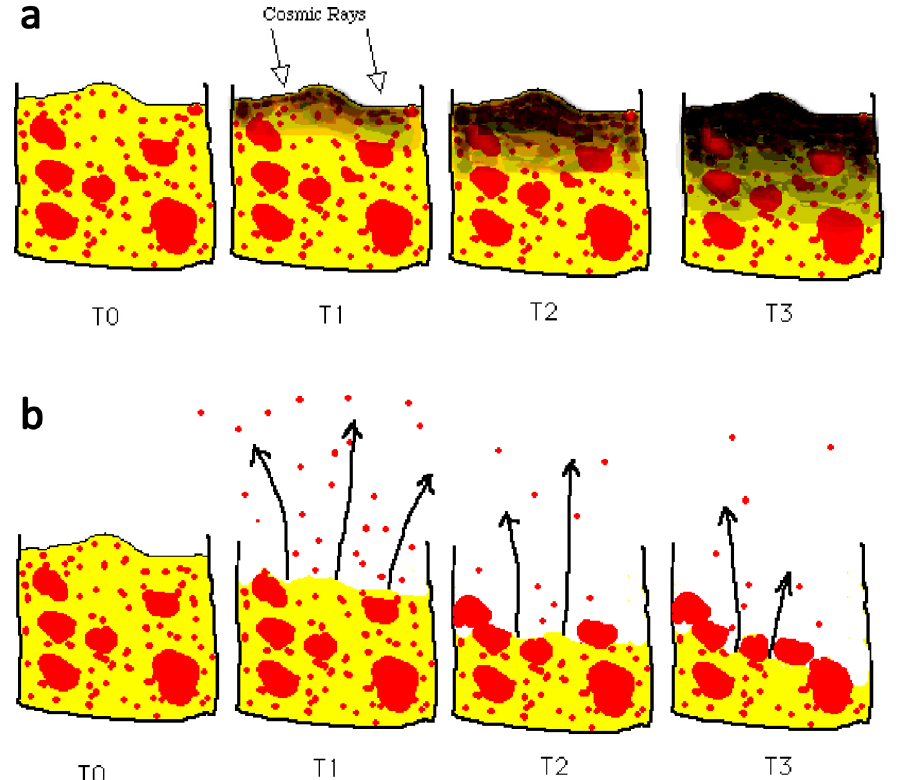
Figure 3. Cross-sections through a piece of a cometary nucleus showing the formation process of two types of cometary mantle: irradiation mantle ( a ) and rubble mantle ( b ). In ( a ), at initial time T0, the comet nucleus consists of a mixture of ices (yellow) and rocks (red). At a later time T1, cosmic rays irradiate the nucleus surface and begin to damage the molecular bonds in the icy material. As time passes (time T2) the degree of damage done by the cosmic rays increases. At the final time T3, the process is saturated. The cosmic rays with energy between several hundreds of MeV to many GeV, responsible for the most extensive damage in terms of depth, produce the greatest effects down to a few meters in ice, so the irradiation layer would be about this thick. The time difference T3–T0 is thought to be about 100 million years. In ( b ) at initial time T0, the comet nucleus consists of a mixture of ices (yellow) and rocks (red). At a later time T1, sunlight heats the nucleus surface from above and sublimates the ice. Dust particles and the smaller rocks are entrained in the gas flow (arrows) and are ejected from the nucleus. Large pieces of rock are too heavy to be lifted. By time T2, about half the surface is covered by large pieces of rock left behind as a lag deposit. At the final time T3, the surface is almost completely sealed by the rubble mantle. The time difference T3–T0 is uncertain but probably very short. Rubble mantles could form within a single orbit. (Credits: D. Jewitt, University of California at Los Angeles, USA).